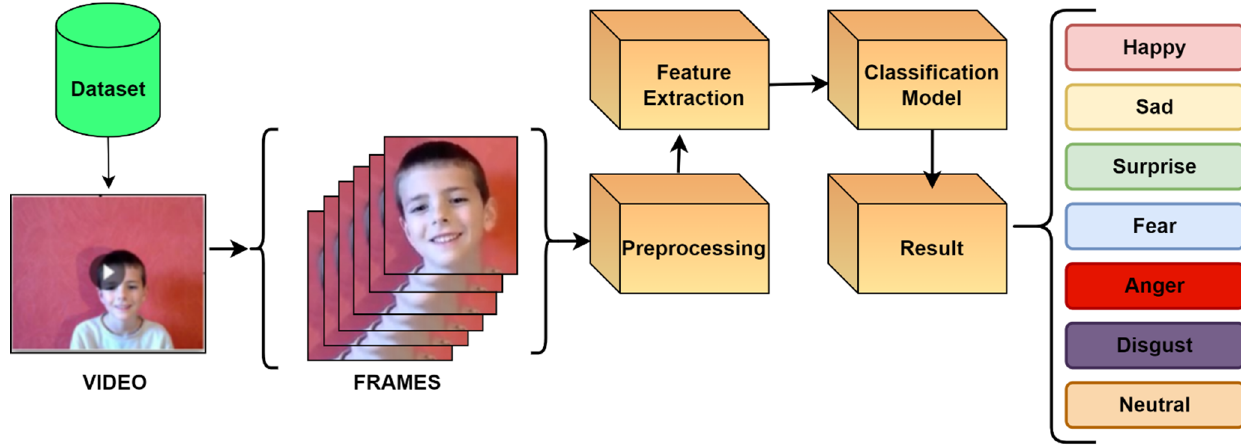
Figure 1. Basic emotion detection using video.